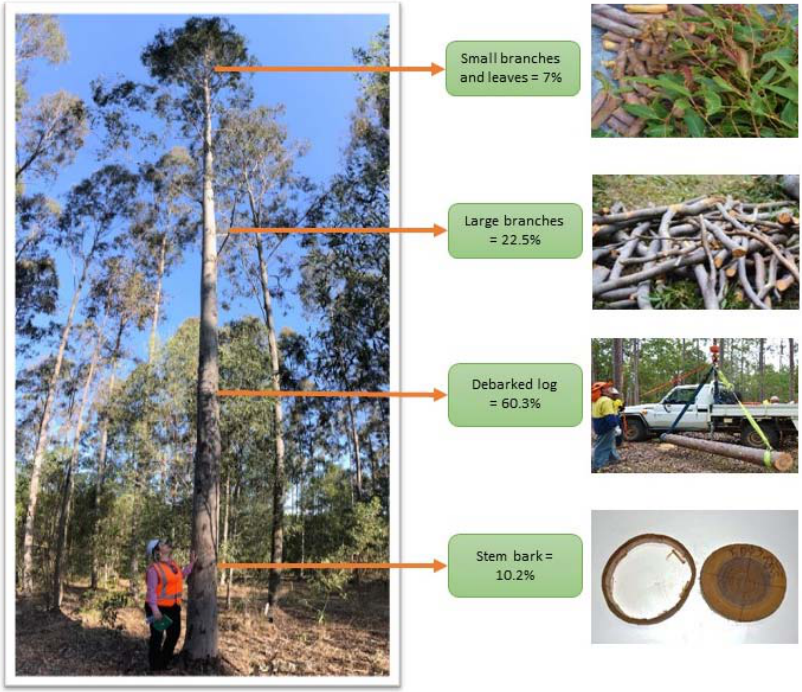
Figure 1. Average proportions of aboveground biomass components of plantation grown spotted gum ( Corymbia citriodora subsp. variegata ) trees, based on data from 52 destructively sampled trees. Please note that debark log biomass was determined from the weight of logs with their bark and the proportions of stem bark and wood estimated indirectly from stem discs from these logs [45].